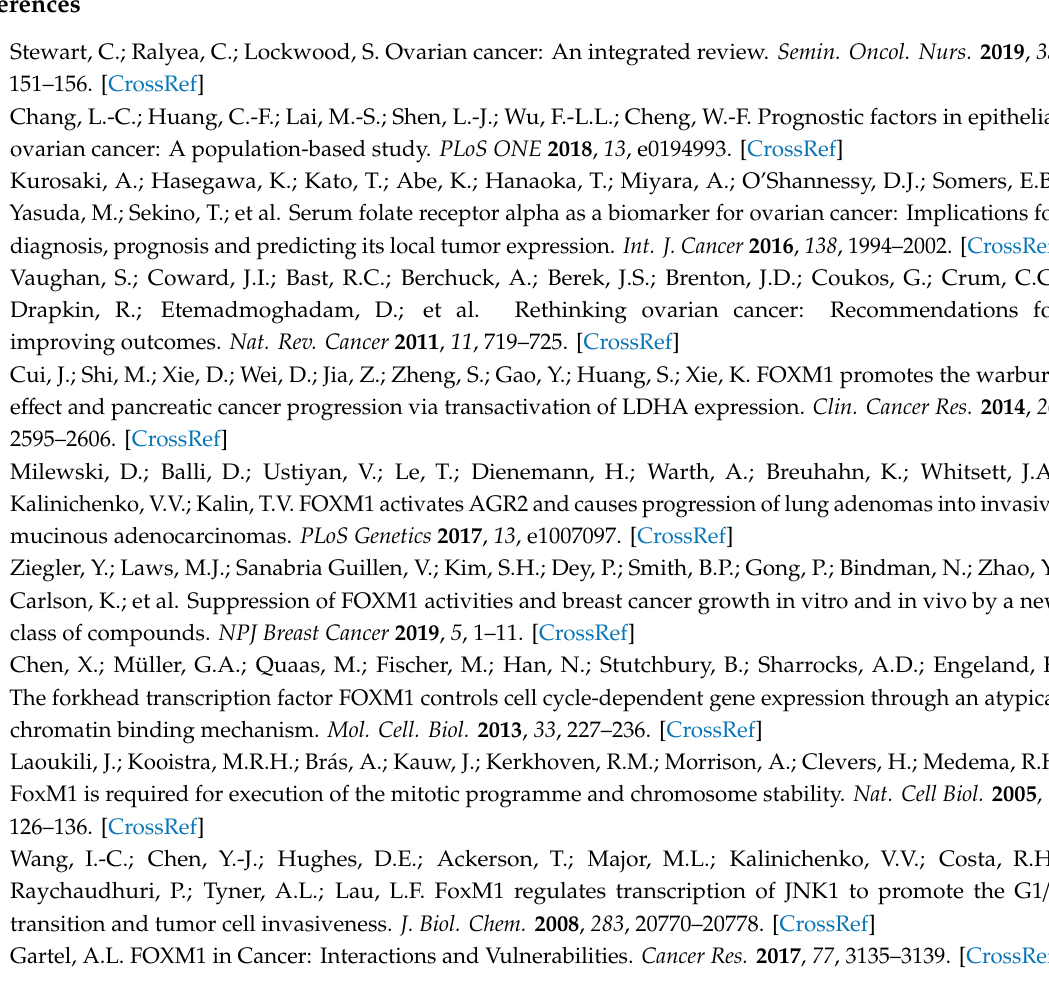
FOXM1 expression level in ovarian cancer patients, Figure S2: Apoptotis marker gene expression by RAME treatment in ovarian cancer cell, Figure S3: The mRNA level of FOXM1 in SKOV-3 and TOV-21G cells; Table S1: The list of 242 down-regulated genes in RAME treated SKOV-3 ovarian cancer cells ( | log2(Fold change) | > 1, p -value <